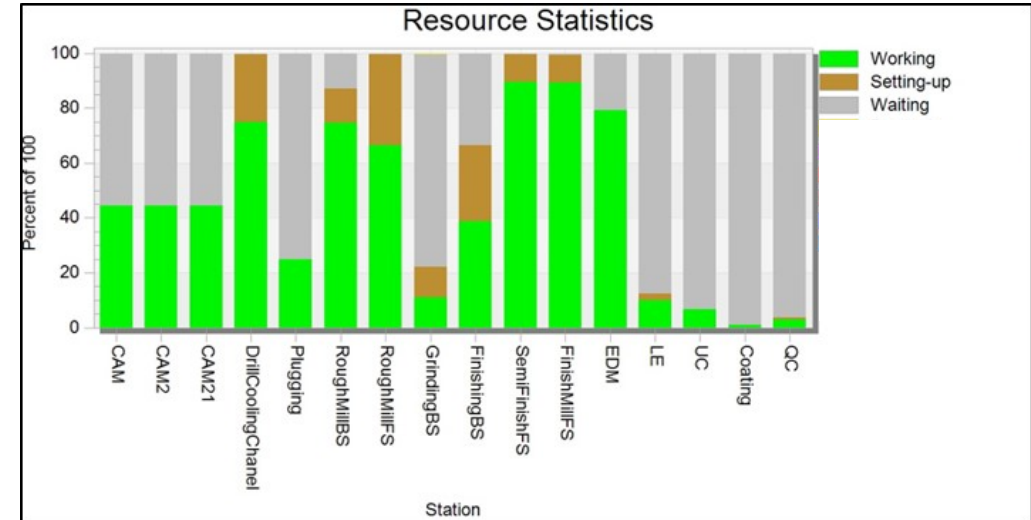
Figure 5. Resource statistics simulation for the CM workflow. The number of inserts produced in one year is 595.